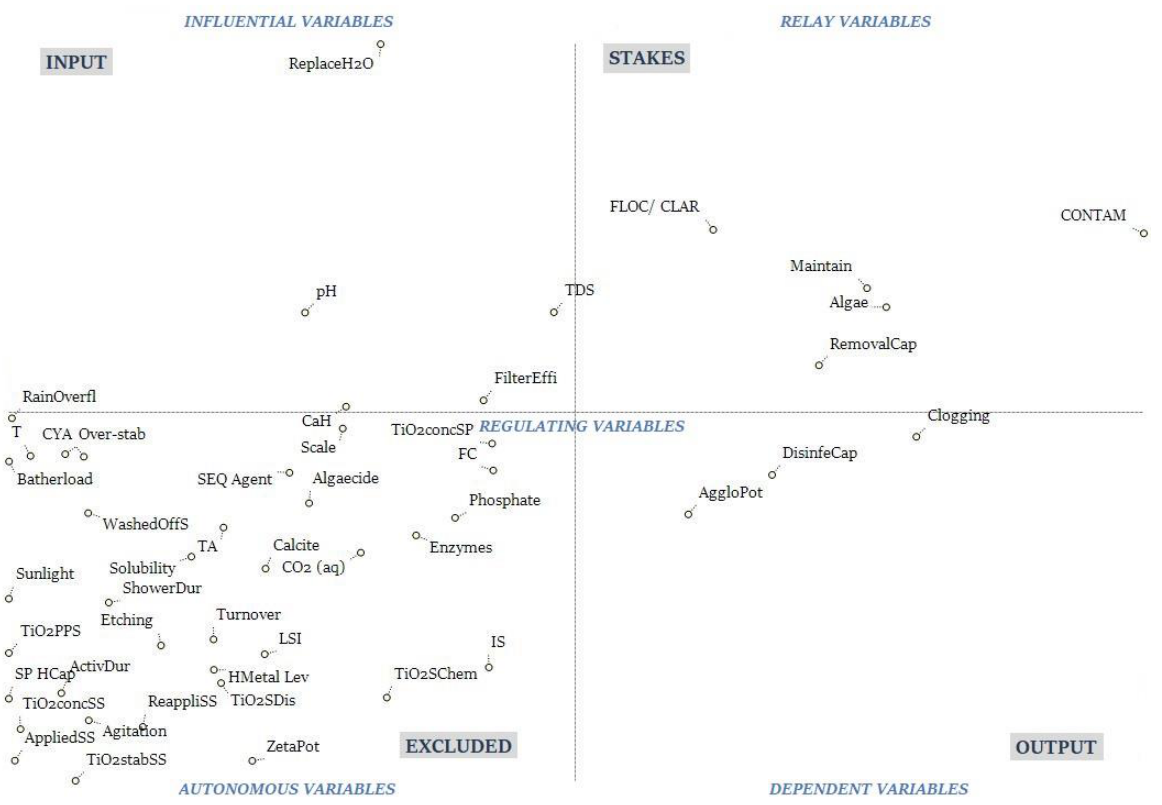
Figure A1. Indirect influence matrix of the model variables, their quadrant allocation and categorisation. Table A3. Direct and indirect influence and dependency rating of all variables according to the MICMAC method—variables are ranked within each category as well as overall, that is compared to all 48 variables (shown in parentheses).